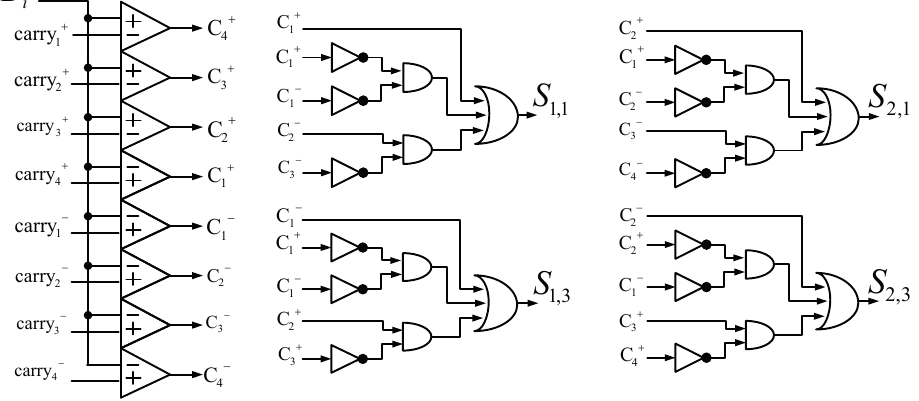
Figure 7. Combinational logic for IGBT pulses, on cascaded cell